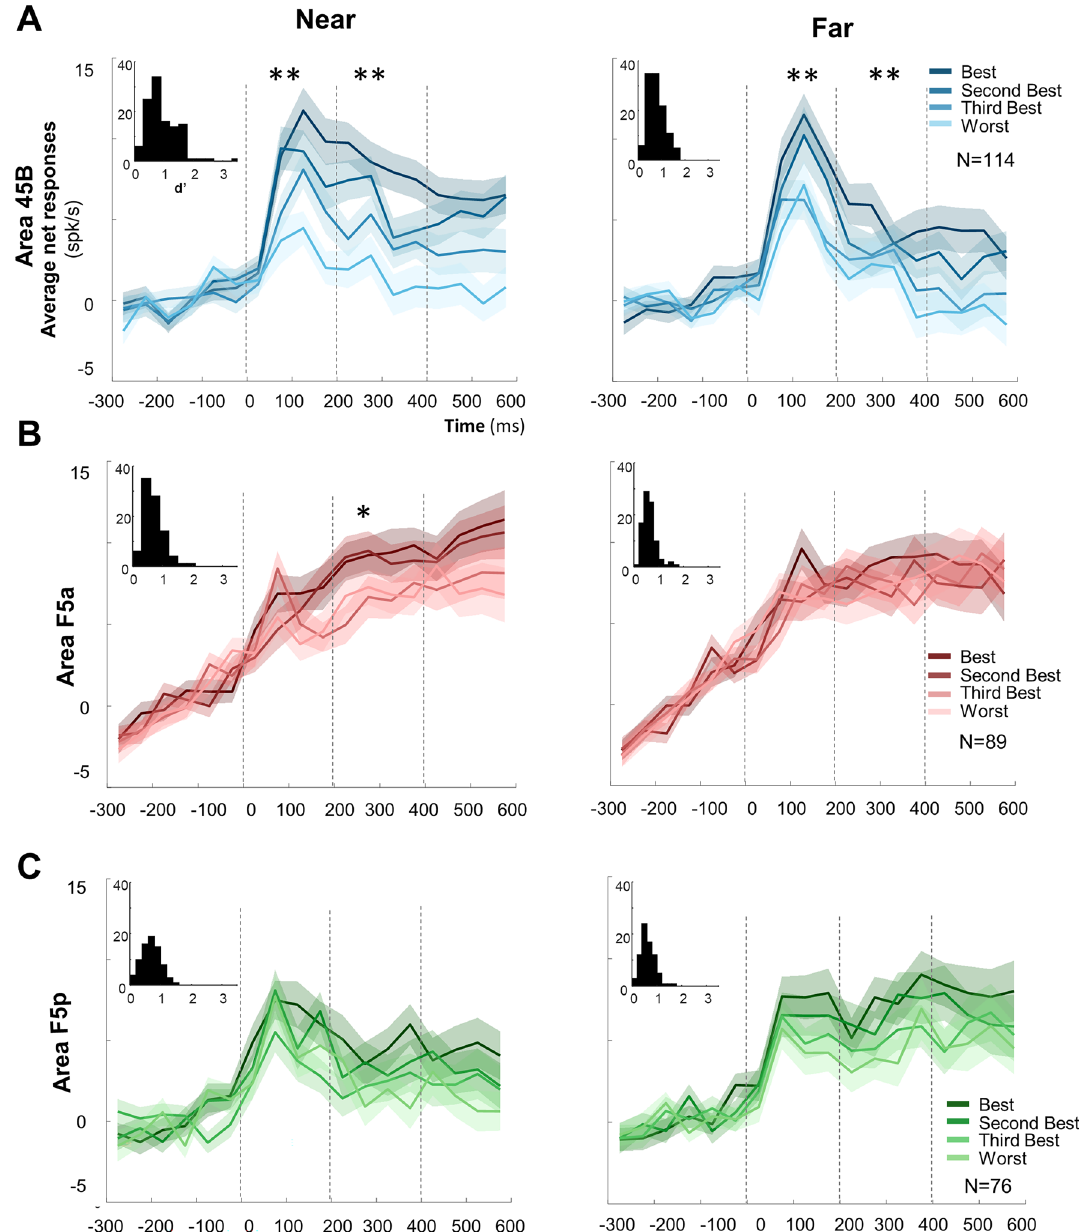
Figure 3. Object selectivity. Average ranked (on odd trials) population response of the even trials of object responsive neurons at Near and Far distance (one-way ANOVA). Average net response across monkeys in area 45B (blue shades; N = 114) ( A ), F5a (red shades; N = 89) ( B ) and F5p (green shades; N = 76) ( C ). Independently from the area, the darkest colors represent the Best object; progressively lighter colors represent lower ranking. Shadows of same color represent sem. The bin size was 50 ms. One asterisk indicates p < 0.05; two asterisks indicate p < 0.01. Insets indicate d ′ distributions for object selectivity, at Near and Far distance, for each